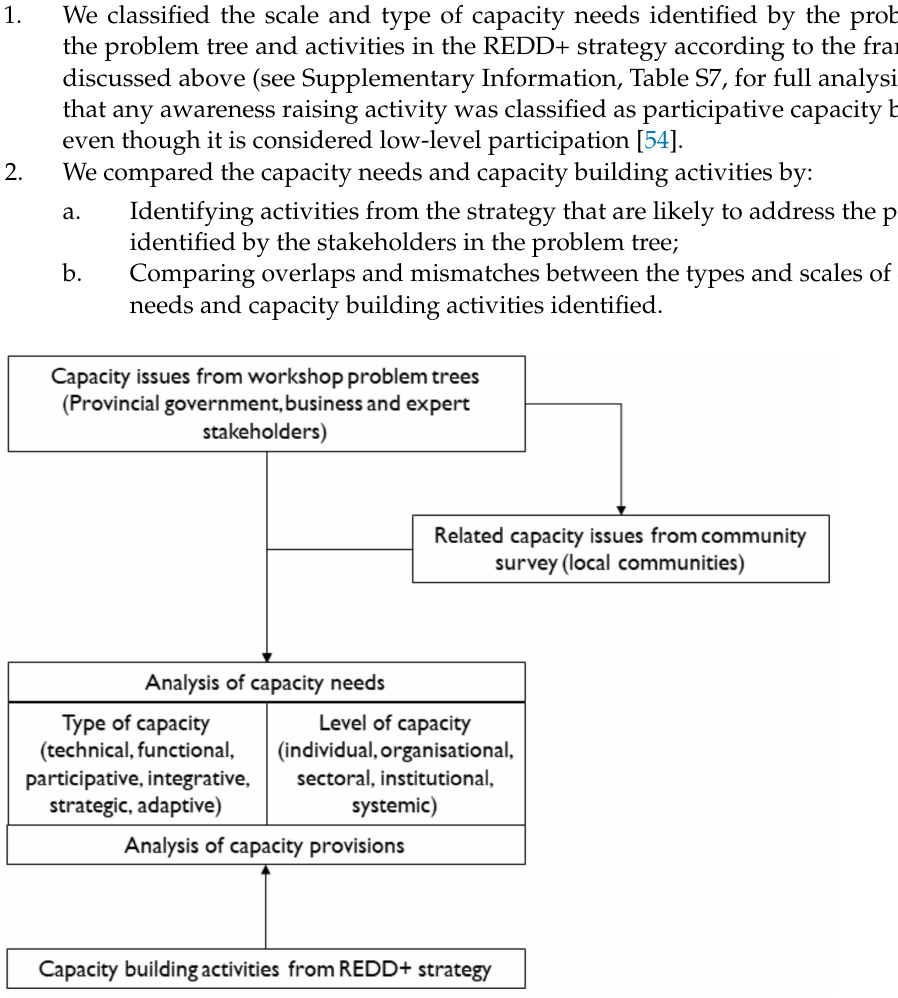
Figure 1. Analytical framework for comparing capacity needs identified by government and expert (workshop) and community (survey) stakeholders with capacity building activities identified in the DRC REDD+